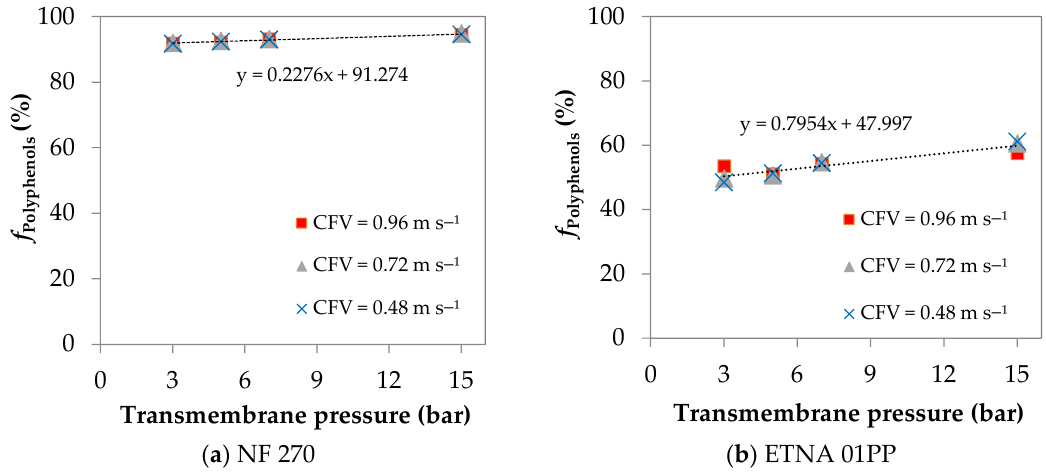
Figure 3. Variation of polyphenols rejection with the transmembrane pressure at three cross-flow feed velocities: ( a ) NF 270 membrane; ( b ) ETNA 01PP membrane.